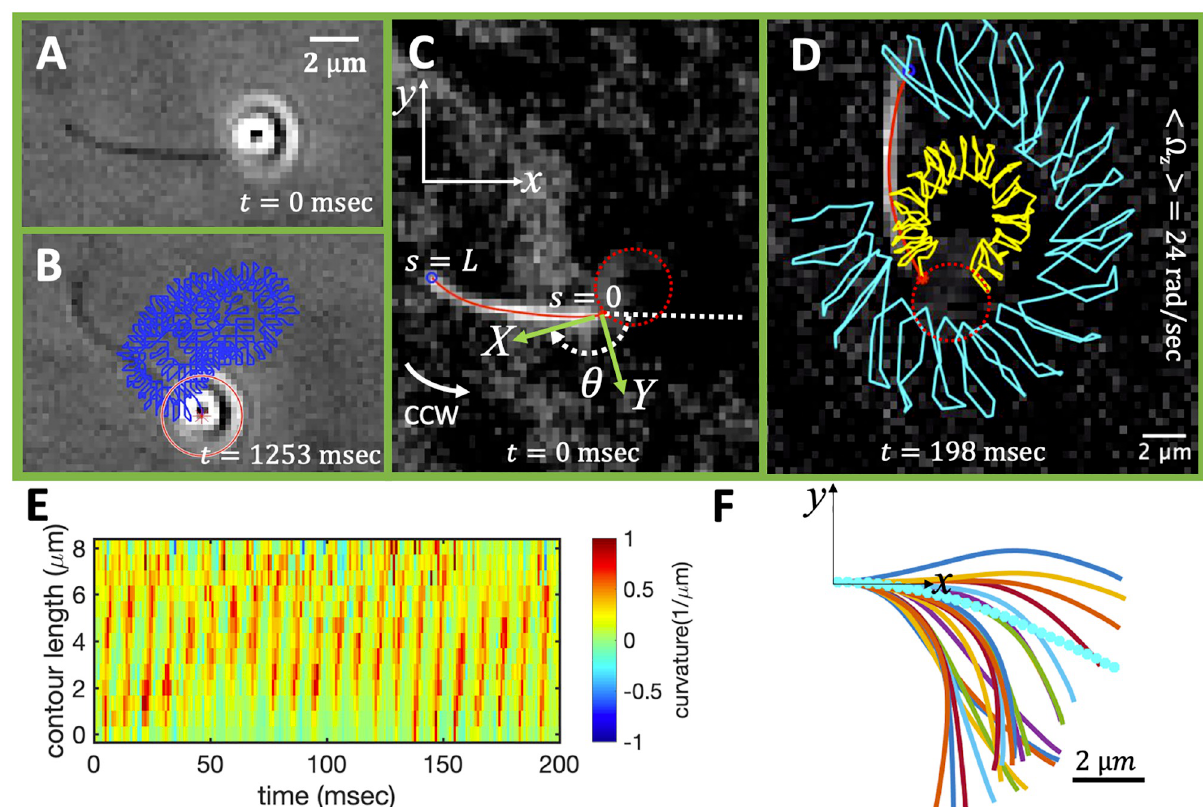
Fig 1. An exemplary experiment showing a flagellum-based bead propulsion. A) An isolated and demembranated flagellum (known as axoneme) from green algae C. reinhardtii is attached to a 1 micron-sized bead. The axoneme is reactivated with 1 mM ATP and beats at around 110 Hz (see S1 Video). B) Over time, the position of the center of the bead, its evolution represented by the blue curve, is propelled on a helical-like trajectory (see S2 Video). (C) The definition of the laboratory and the swimmer-fixed frame. As the flagellum beats, the micro-swimmer swims counterclockwise (CCW) in the microscope’s field of view effectively in 2D. D) The traces of the basal (yellow line) and distal tip (cyan line) of the flagellum tracked for 198 sec. (E) Curvature waves initiate at the basal end of axoneme ( s = 0) which is attached to the bead, and propagate toward the distal tip ( s = L ) at the frequency of about 110 Hz. F) The axonemal shapes averaged over one beat cycle results in a circular arc with mean curvature of about -0.2 μ m − 1 . This static component of the axonemal curvature results in a curved swimming trajectory and in the absence of this component, the bead is propelled on a straight trajectory. The experimental techniques used to record the motion of the beads and the flagella are described in Ref. [14]. Please note that in this experiment, the bead-axoneme attachment appears to be asymmetric but 3D microscopy techniques are required to distinguish a symmetric versus an asymmetric